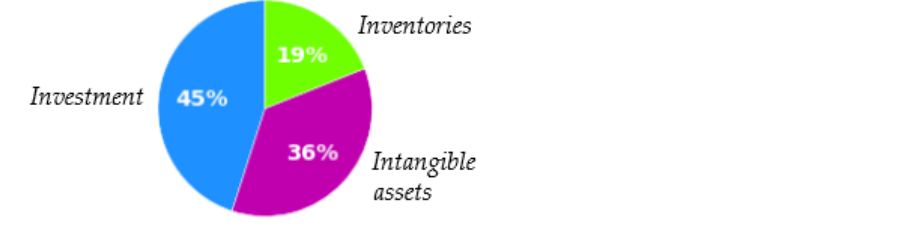
Figure 7. Answers for question of how companies to account for holdings of cryptocurrencies?